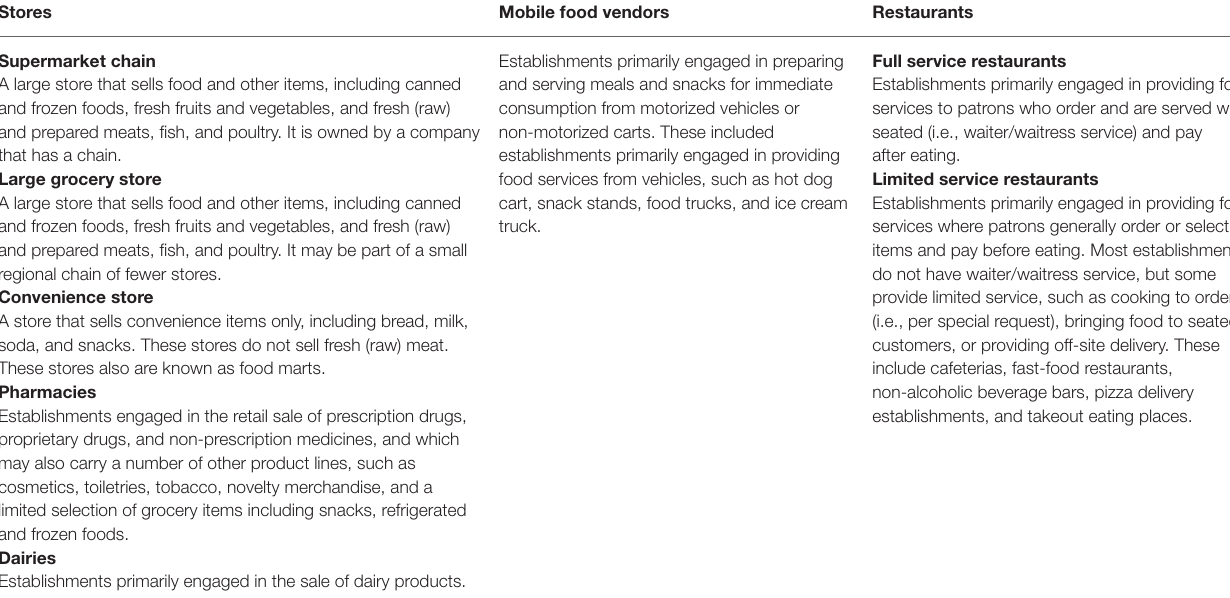
TABLE 1 | Categorization and definition of surveyed food establishments (adapted from North American Industrial Classification System and the World Bank). Stores Mobile food vendors